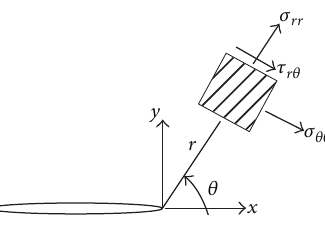
Figure 1: Plate with a central